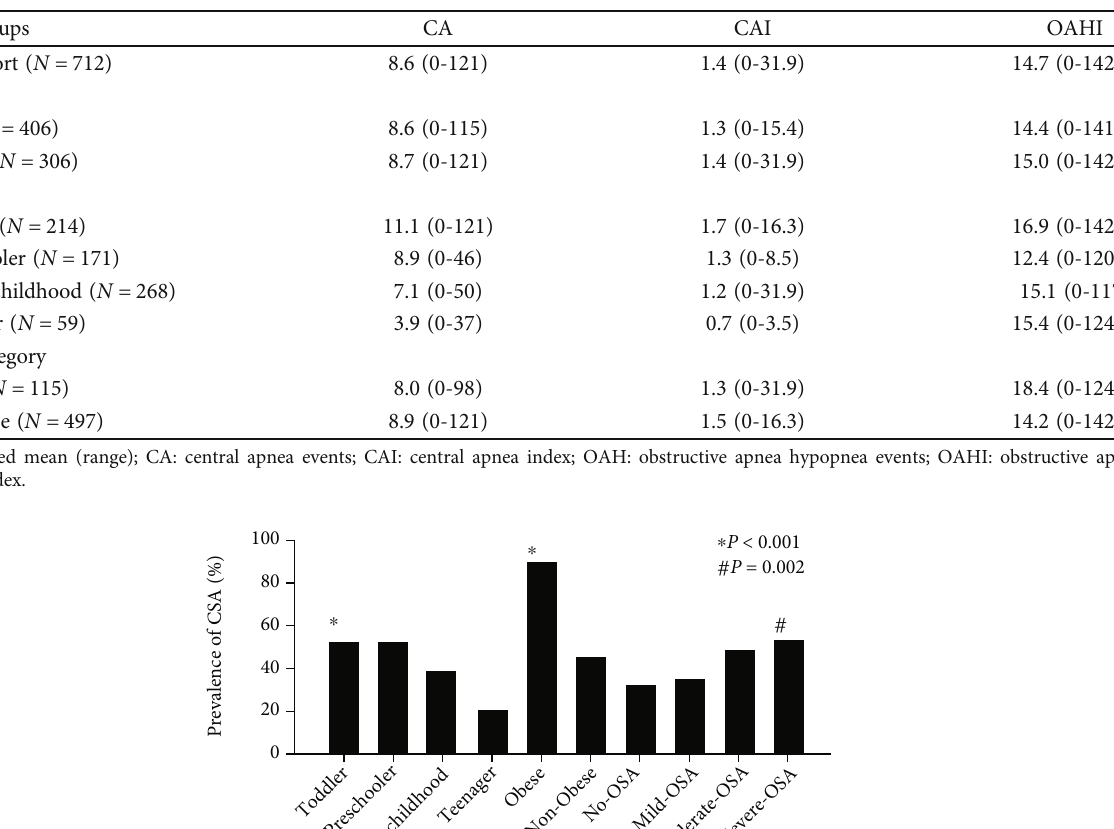
Table 1: Demographics and polysomnography fi ndings.